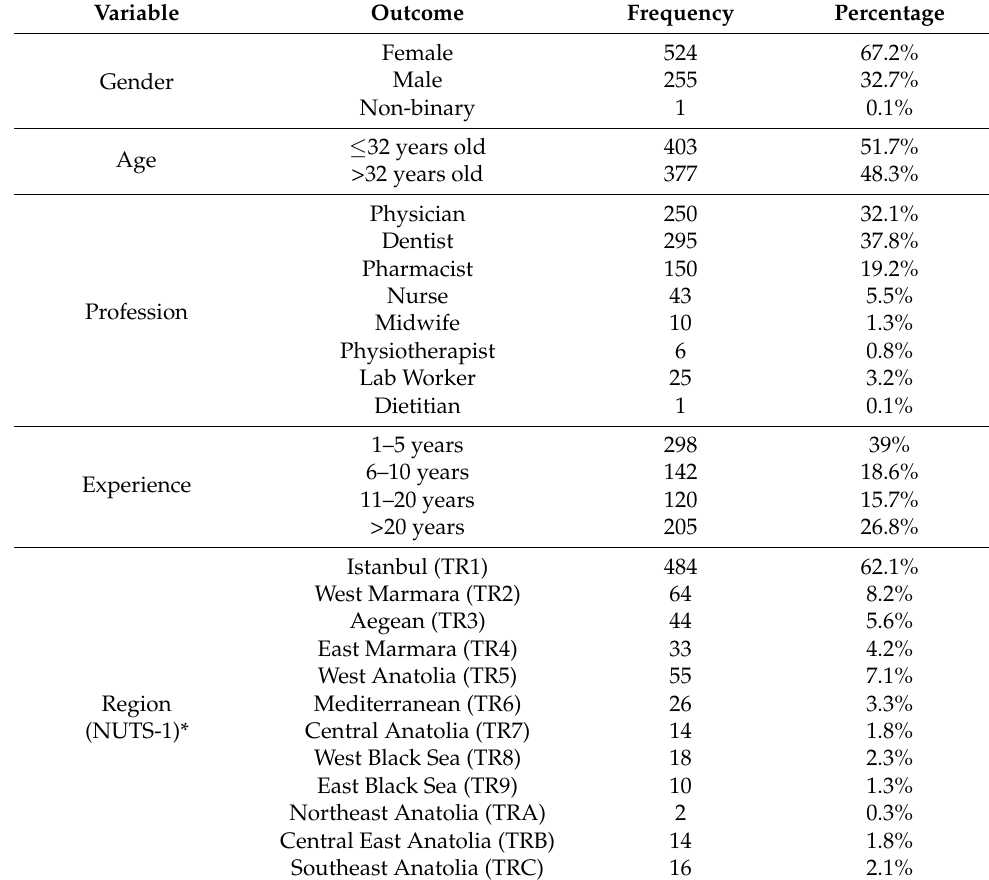
Table 1. Demographic characteristics of Turkish healthcare workers vaccinated by CoronaVac,